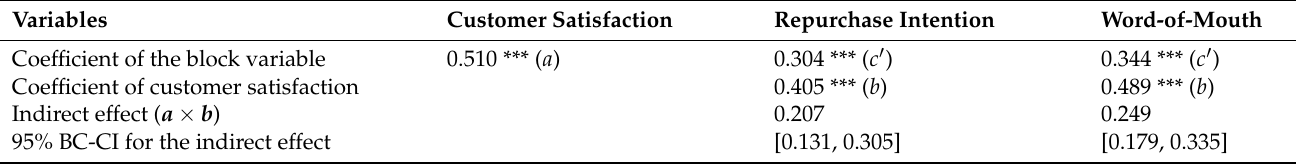
Table 5. Indirect and direct effects of customer experience (in)consistency on service outcomes.